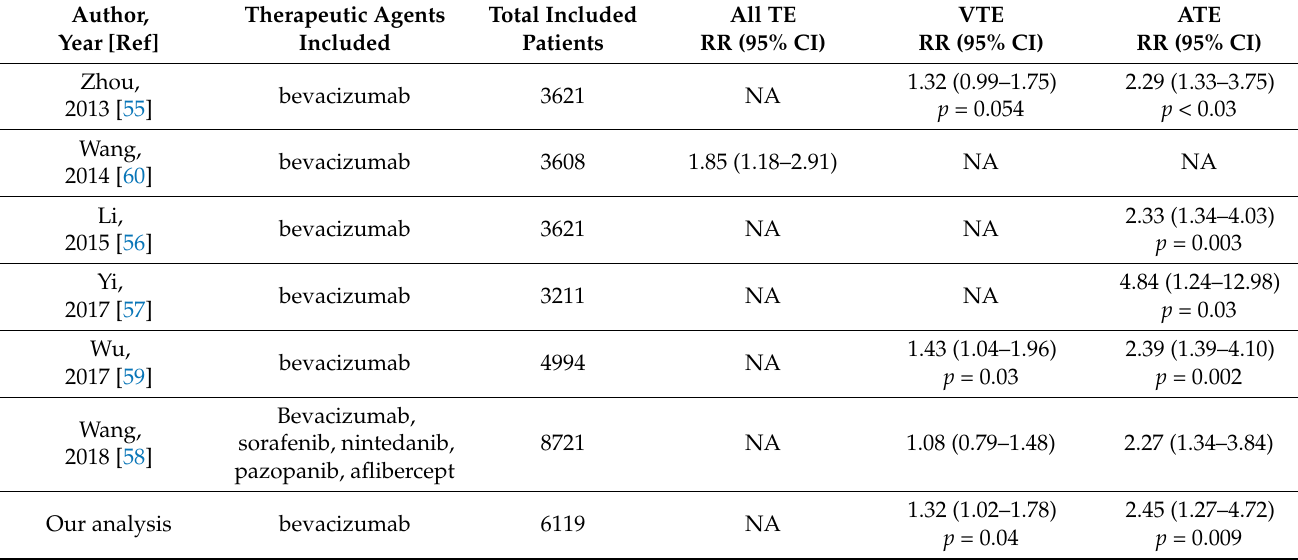
Table 4. Meta-analyses on the thromboembolic risk with various angiogenesis inhibitors in ovarian